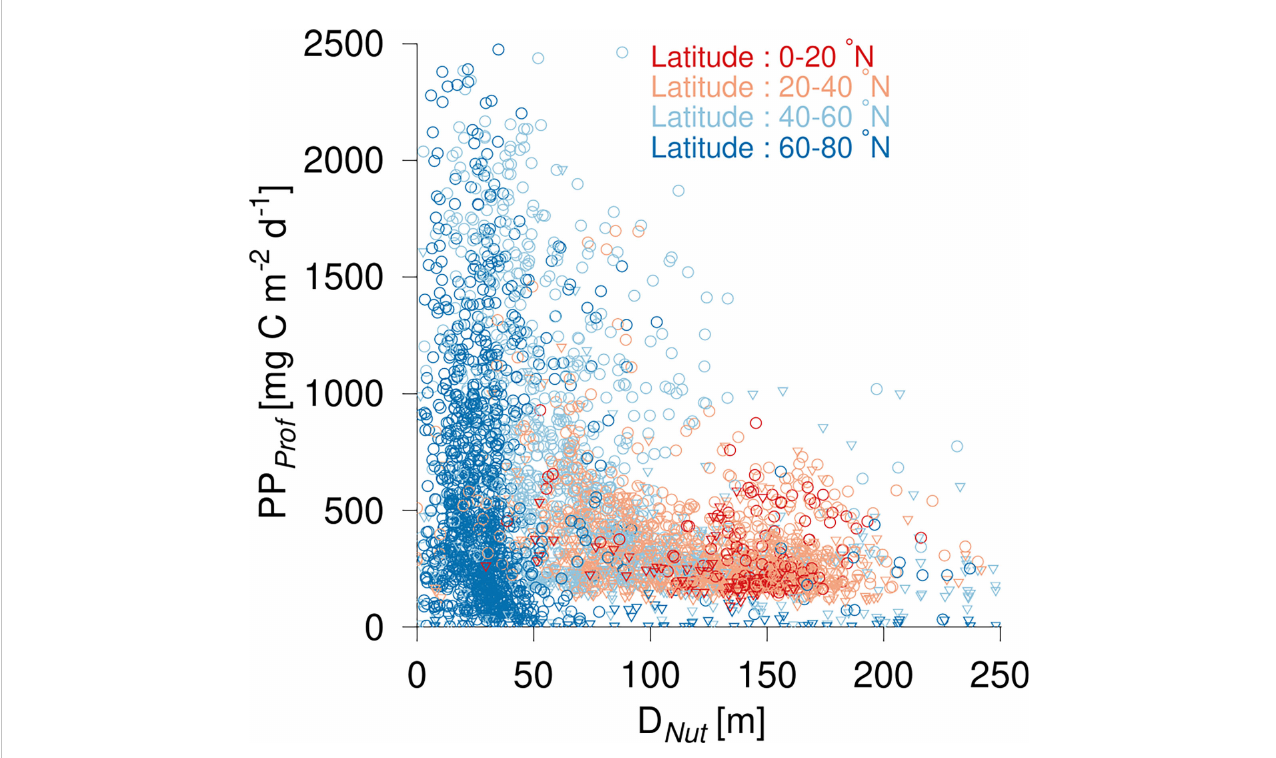
FIGURE 4 Primary production (PP Prof ) versus nutricline depth (D Nut ). Color shading shows the latitude of the corresponding pro fi le. Observations are shown during the growth season (April-October, circles) and during winter time (November-March,